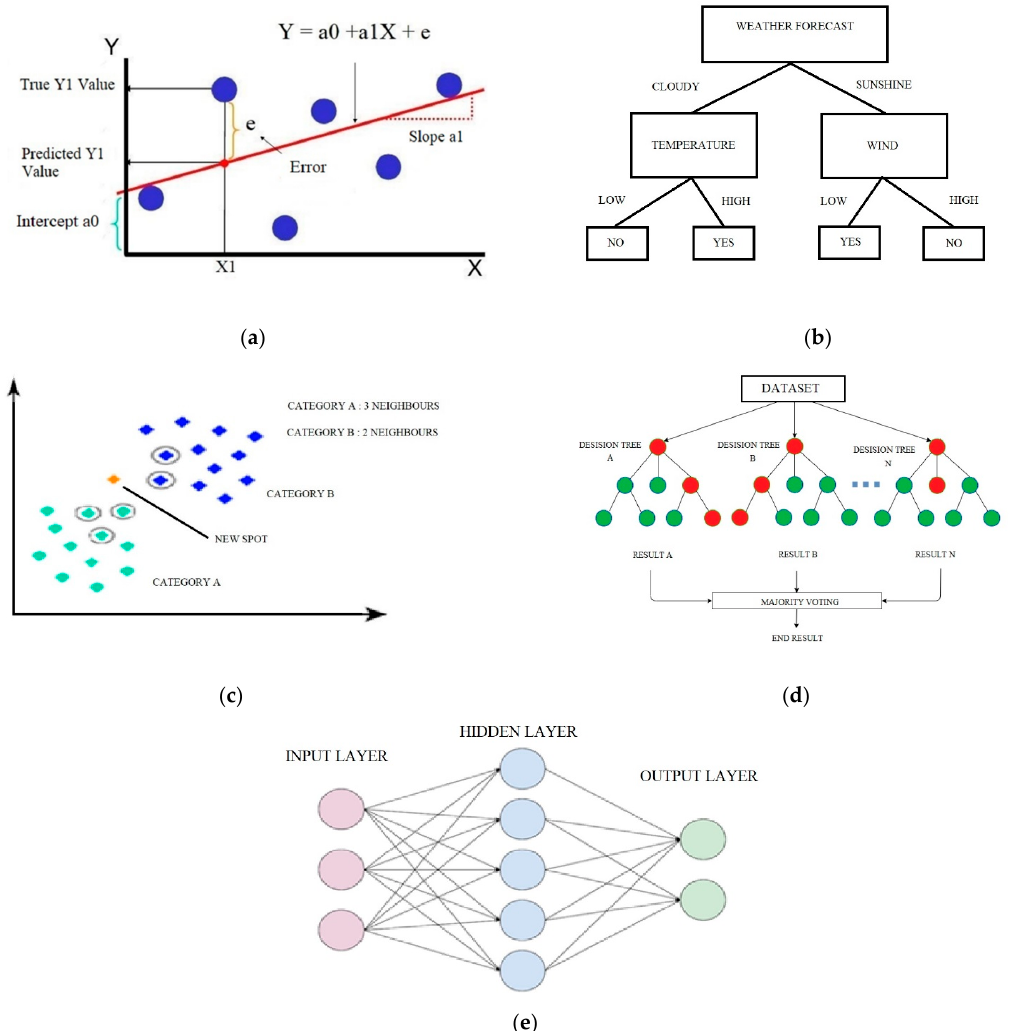
Figure 4. Graphical representation of the ML algorithms. ( a ) Linear Regression graphical representation. ( b ) Decision Tree example. ( c ) Match value (spot) with k to nearest neighbors. ( d ) Random Forest example. ( e ) ANN example with one hidden layer.